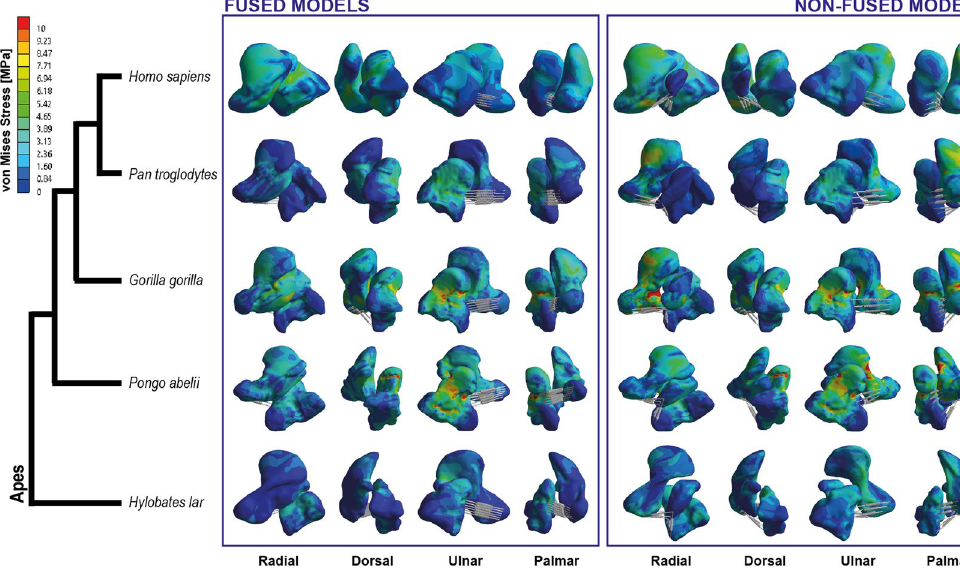
Figure 2. von Mises stress distribution of the analysed sample for both the fused and non-fused models. For simplicity, views were defined according to the human anatomical standard